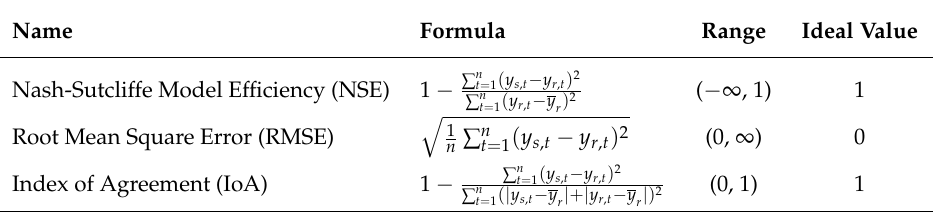
Table 1. Model efficiency performance measures.